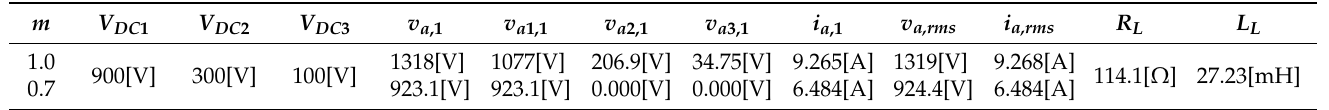
Figure 7. Schematic of the simulation. Table 1. Simulated parameters.